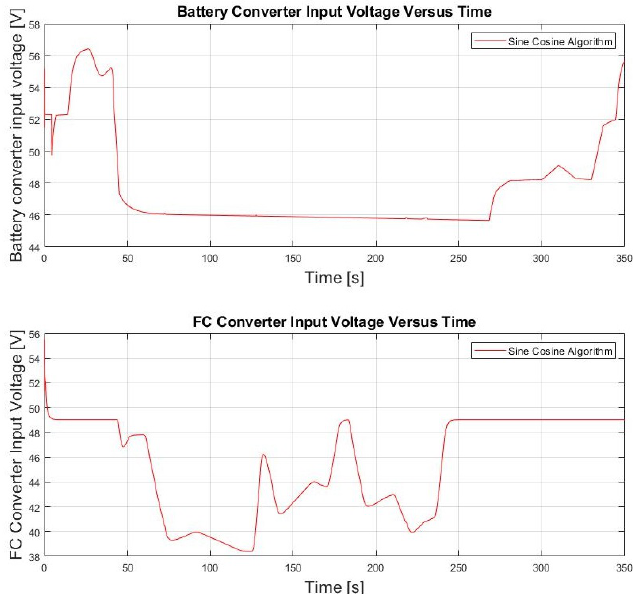
Figure 17. Variation of input voltage of DC/DC converters during